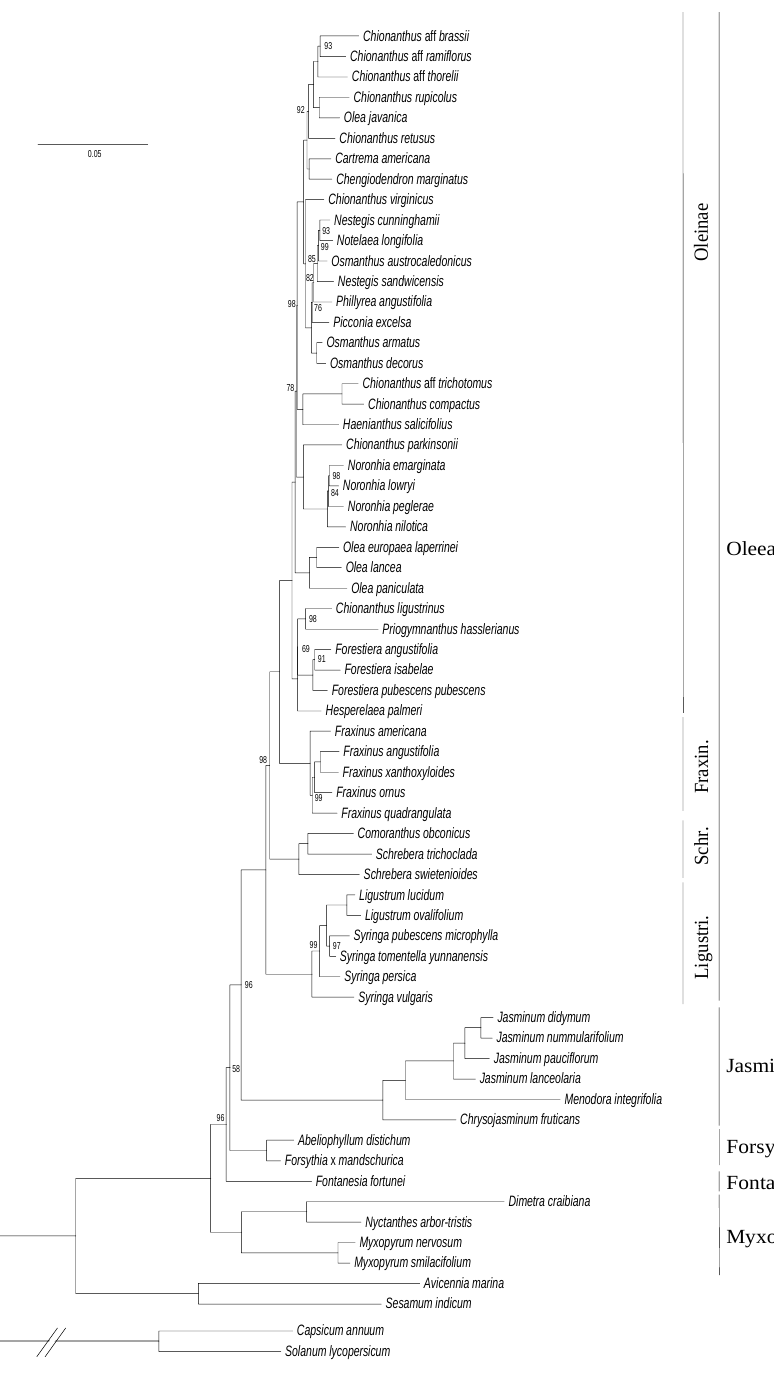
Figure 5. Maximum likelihood phylogenetic tree of Oleaceae based on phyB-1 ( a and b ) and phyE-1 nuclear genes. Oleeae phyB-1a was arbitrarily aligned with phyB-1 of other tribes. The tree was rooted on the split with Solanaceae. The scale is in substitution per site. Ultrafast bootstrap support values are indicated on nodes when inferior to